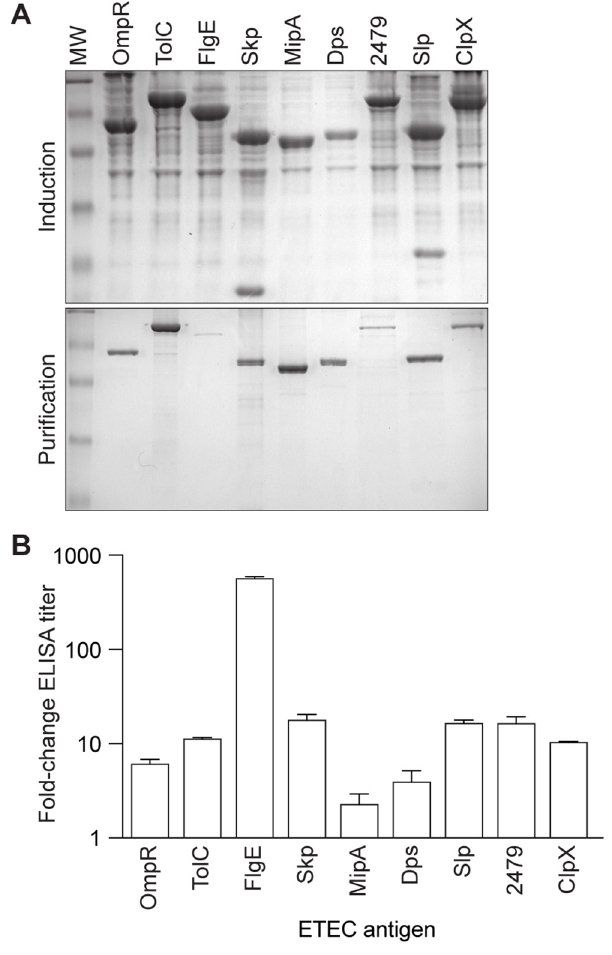
Fig 1. Antigen selection, purification, and serum IgG responses. A. Purification of ETEC antigens identified after bacterial fractionation and mass spectrometry. Top panel, induction in E . coli BL21 (DE3) cells; bottom panel, purification over glutathione S -transferase (GST) resin. B. Serum IgG responses in mice. Data are plotted as the fold-change in serum IgG after immunization with the indicated antigens, n =